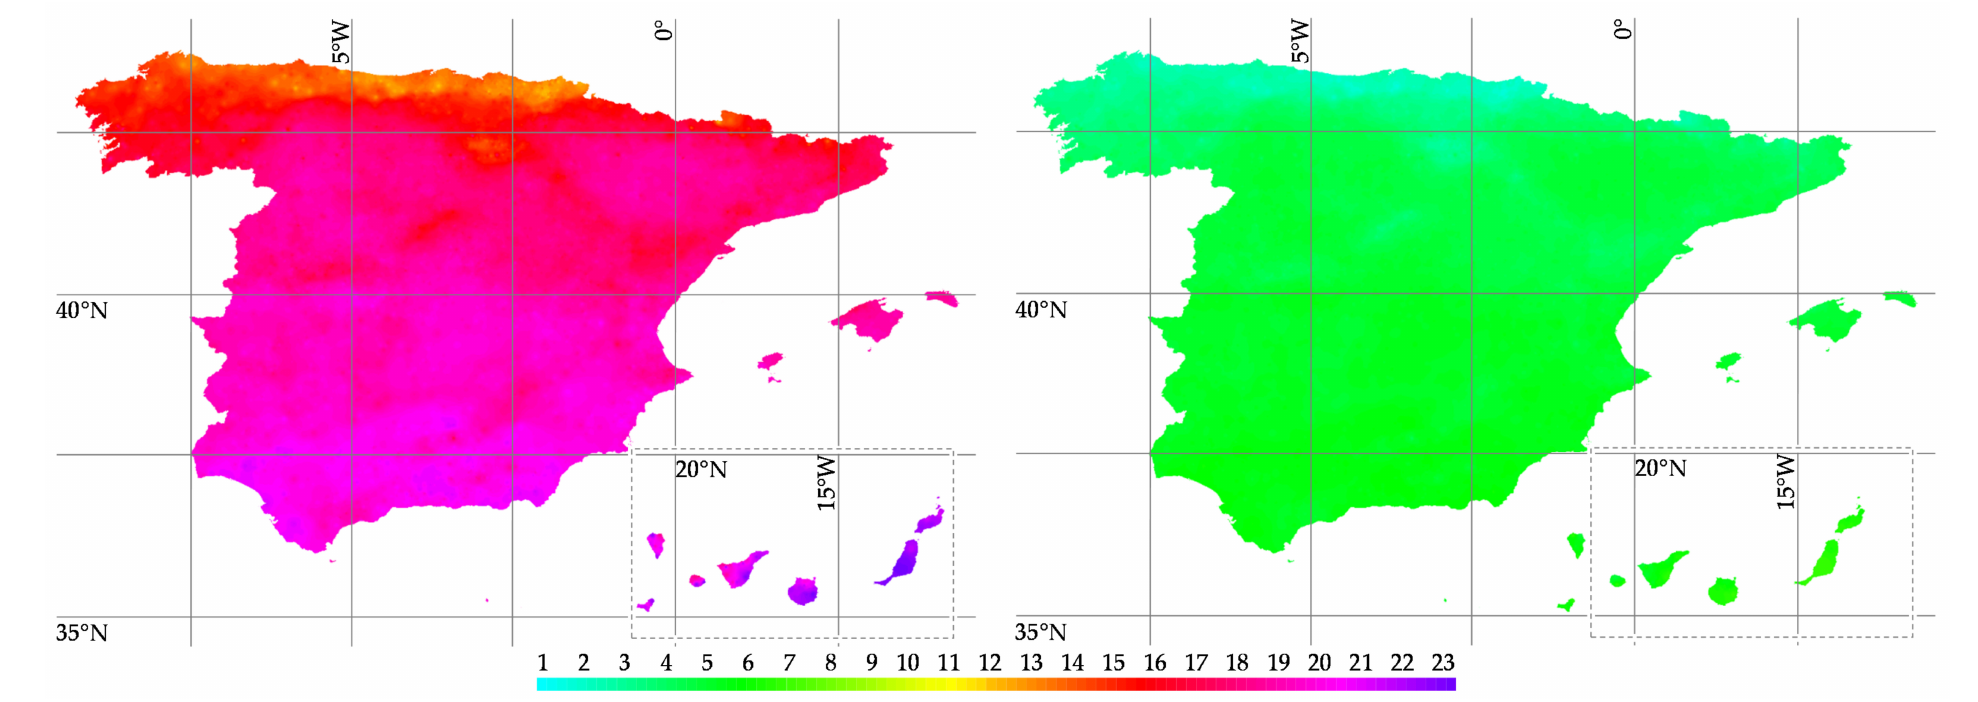
Figure 6. PV IRR in % (S1 (consumption saving scenario) left , S2 (surplus sale scenario) right ).